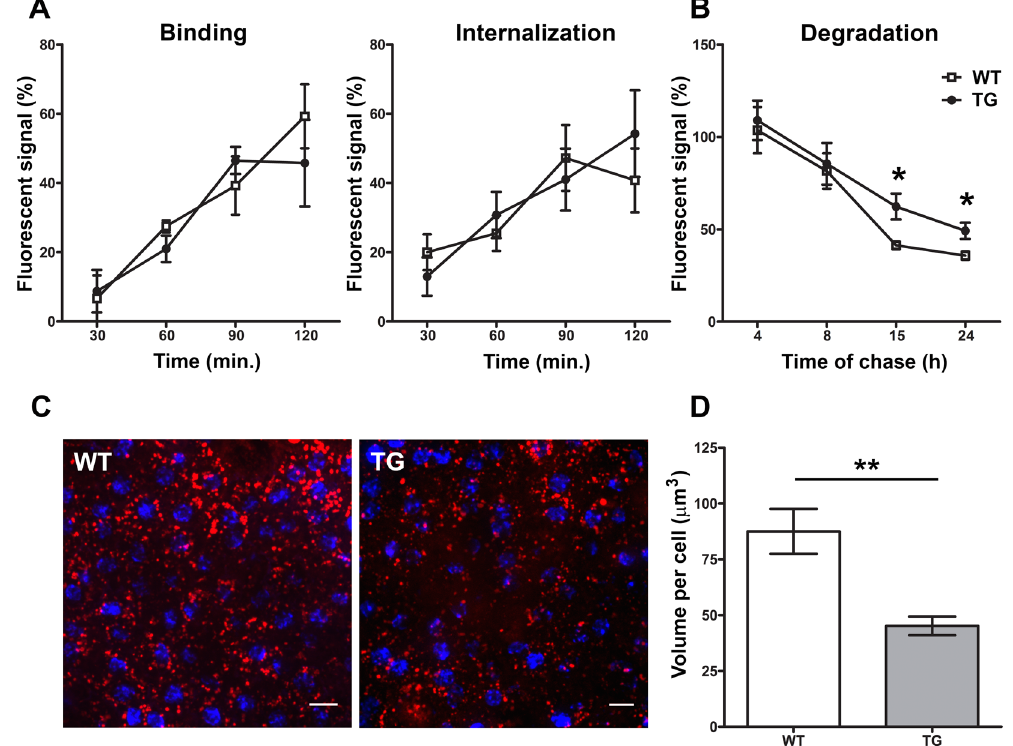
Figure 1. Degradation of TG POS is delayed. Numbers of phagolysosomes are reduced. In vitro : ( A ) Graphs representing the kinetics of binding (OS bound but not internalized) and internalization (OS bound and internalized). Human RPE were presented with Alexa Fluor 488-labeled POS, isolated from WT (white squares) or TG (black circles) mice, for 120 minutes. Kinetics of POS binding and internalization were calculated using total fluorescence and internal signal from phagosomes after quenching. Data are expressed as mean ± SEM; n = 3–4 independent experiments. ( B ) Graph showing phagocytic pulse-chase assay. Human RPE were presented with POS for 2 hours, and fluorescence levels were quantified at different times following POS removal. Fusion of phagosomes containing fluorescently-labelled POS with acidified lysosomes, leads to POS degradation and loss of fluorescence signal, expressed here on the y axis as percentage of signal at time zero of presentation. Data are expressed as mean ± SEM; n = 3–5 independent experiments. * P ≤ 0.05. Live cell imaging: ( C ) Representative confocal images of acidified phagolysosomes labelled with pH sensitive dye (red) and nuclei stained with DAPI (blue) on freshly dissected RPE flatmounts, from WT (left) and TG (right) mice. Animals were culled 2 hours after light onset (7AM). (Scale bar: 10 μ m). ( D ) Histogram showing the volume of acidified phagolysosomes occupied inside single RPE cells. Data are expressed as mean ± SEM; n = 13 microscope fields per group. ** P ≤